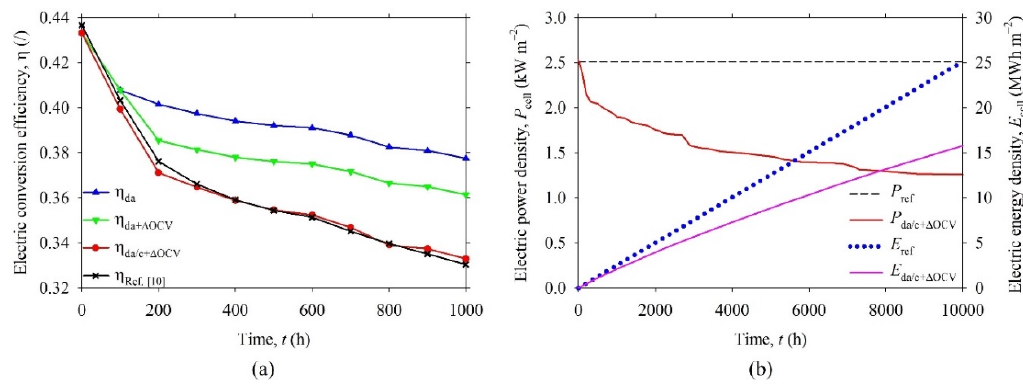
Figure 7. ( a ) Relative TPB density and ( b ) output voltage ( V cell ) of the SOFC as a function of time from 0 to 1000 h. ( c ) Relative TPB density and ( d ) output voltage ( V cell ) of the SOFC as a function of time from 0 to 10,000 h. The anode and cathode exponential coefficients, κ a = 3 and κ c = 3, and the anode and cathode growth coefficients, k a = 2.1 × 10 − 21 m 3 h − 1 and k c = 1.4 × 10 − 21 m 3 h − 1 , are considered.